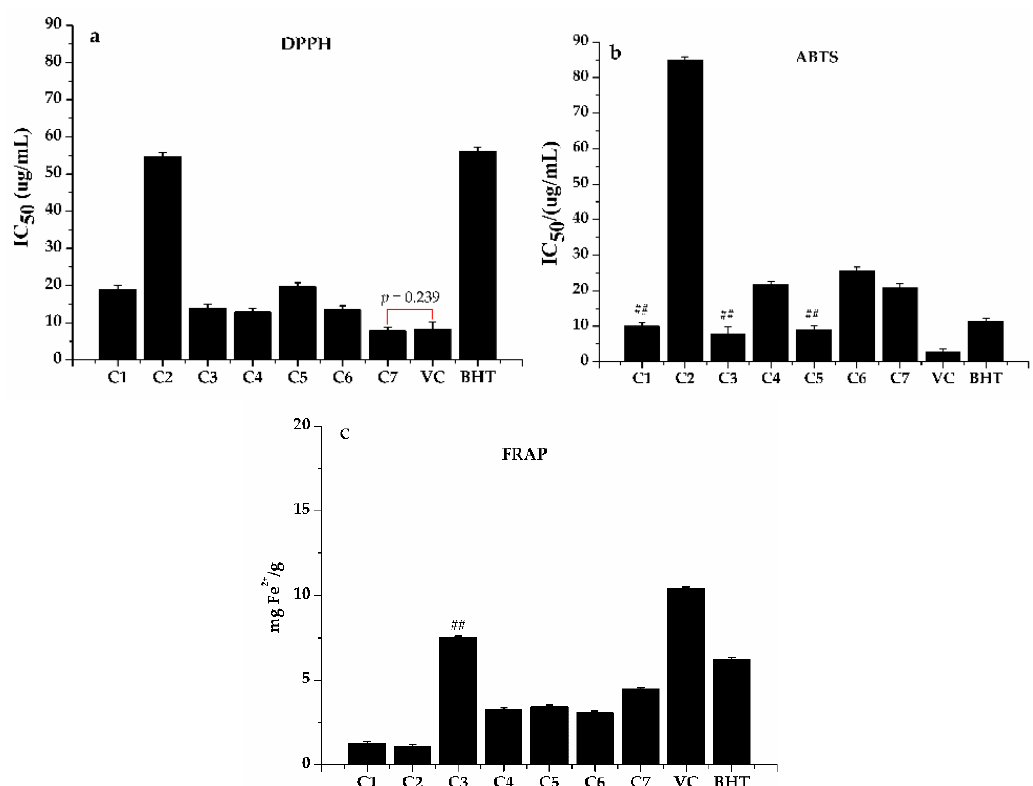
Figure 7. The antioxidant activity of compounds from the EA fraction, C1 = dihydroquercetin, C2 = acacetin, C3 = quercetin, C4 = isoquercitin, C5 = dehydrodicatechin A, C6 = trans-ferulic acid, and C7 = caffeic acid. ( a ) The IC 50 value of DPPH radical scavenging assay, ( b ) The IC 50 value of ABST radical scavenging assay, and ( c ) ferric-ion reducing antioxidant power (FRAP) assay. ## p < 0.01 compared with the positive control of BHT.